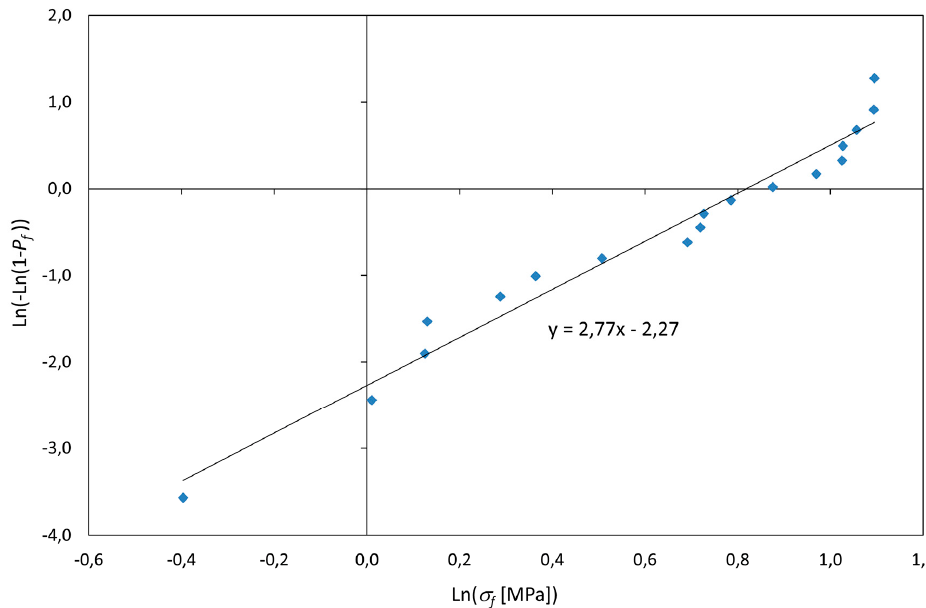
Figure 5. Graphical fitting of the Weibull distribution, where P f denotes the failure probability and σ f denotes each failure stress calculated according to Equation (5).